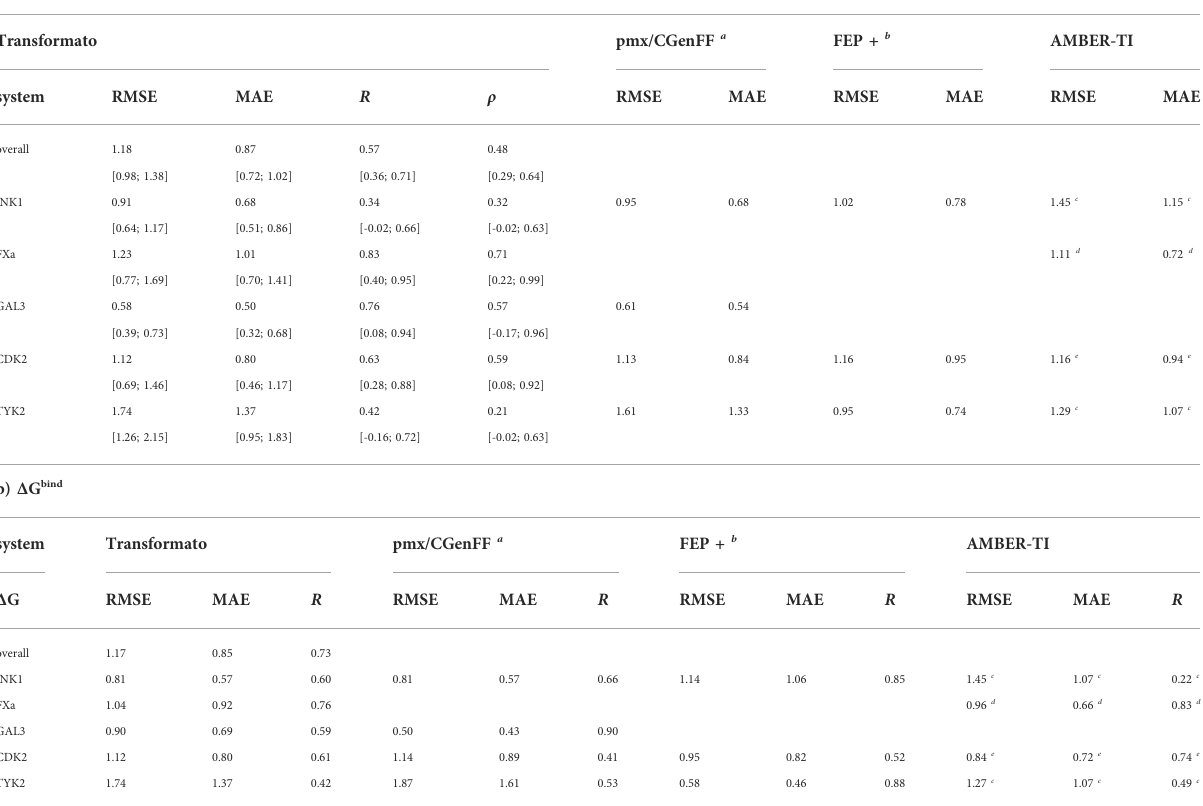
TABLE 2 Comparison of a) relative and b) absolute binding free energy differences calculated with transformato, pmx/CGenFF, FEP+ and AMBER-TI with experiment. The root mean squared error (RMSE), the mean absolute error (MAE), both in kcal/mol, as well as the Pearson ’ s correlation coef fi cient R , and the Spearman ’ s rank correlation coef fi cient ρ are listed. For the ΔΔ G bind results obtained with transformato in a) we also report bootstrapped error estimates for RMSE, MAE, R and ρ